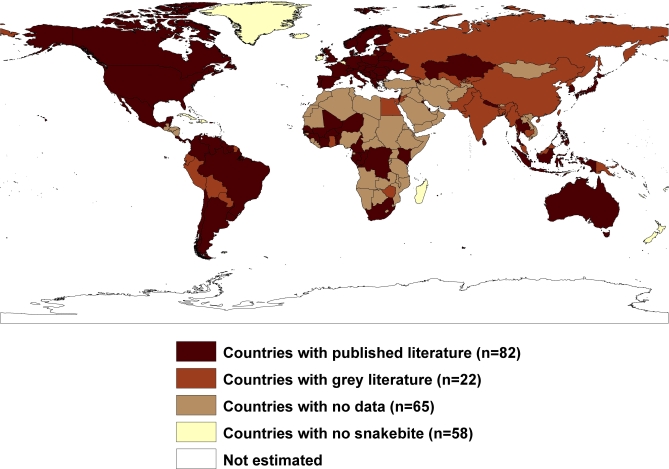
Countries with Data on Snakebite Mortality